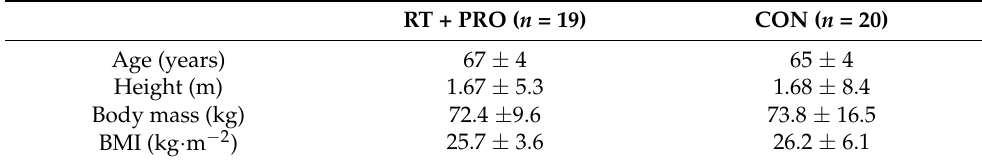
Table 1. Participant Characteristics (Mean ± SD ).